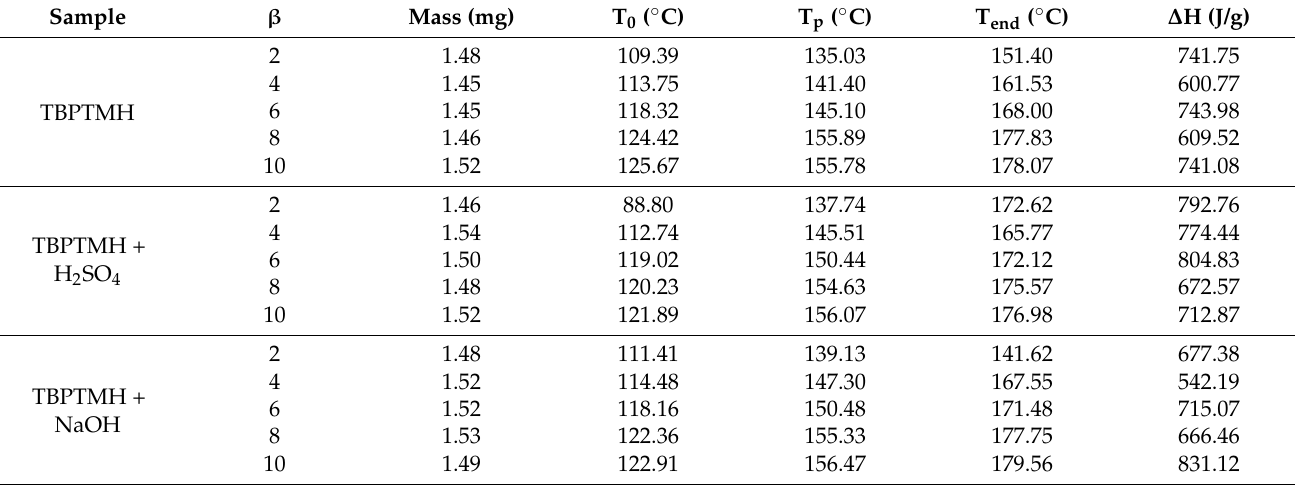
Table 3. DSC characteristic parameter values.